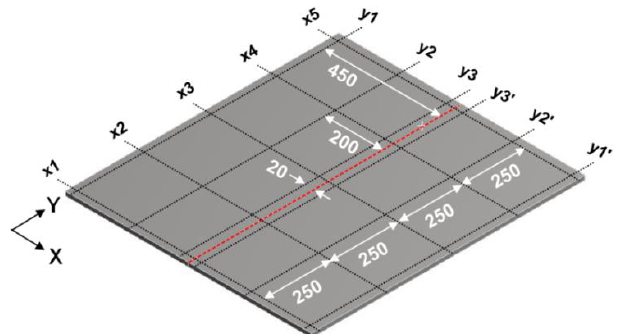
Figure 7. Vertical and horizontal gridlines for welding deformation comparison.